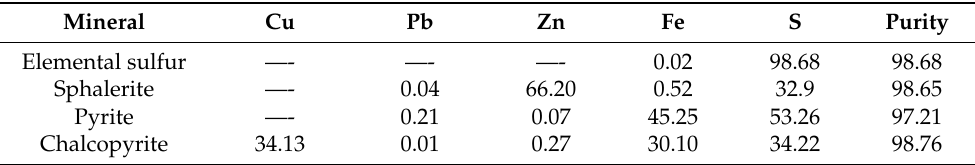
Table 1. Chemical compositions of pure minerals of elemental sulfur, sphalerite, pyrite and chalcopy- rite (wt %).